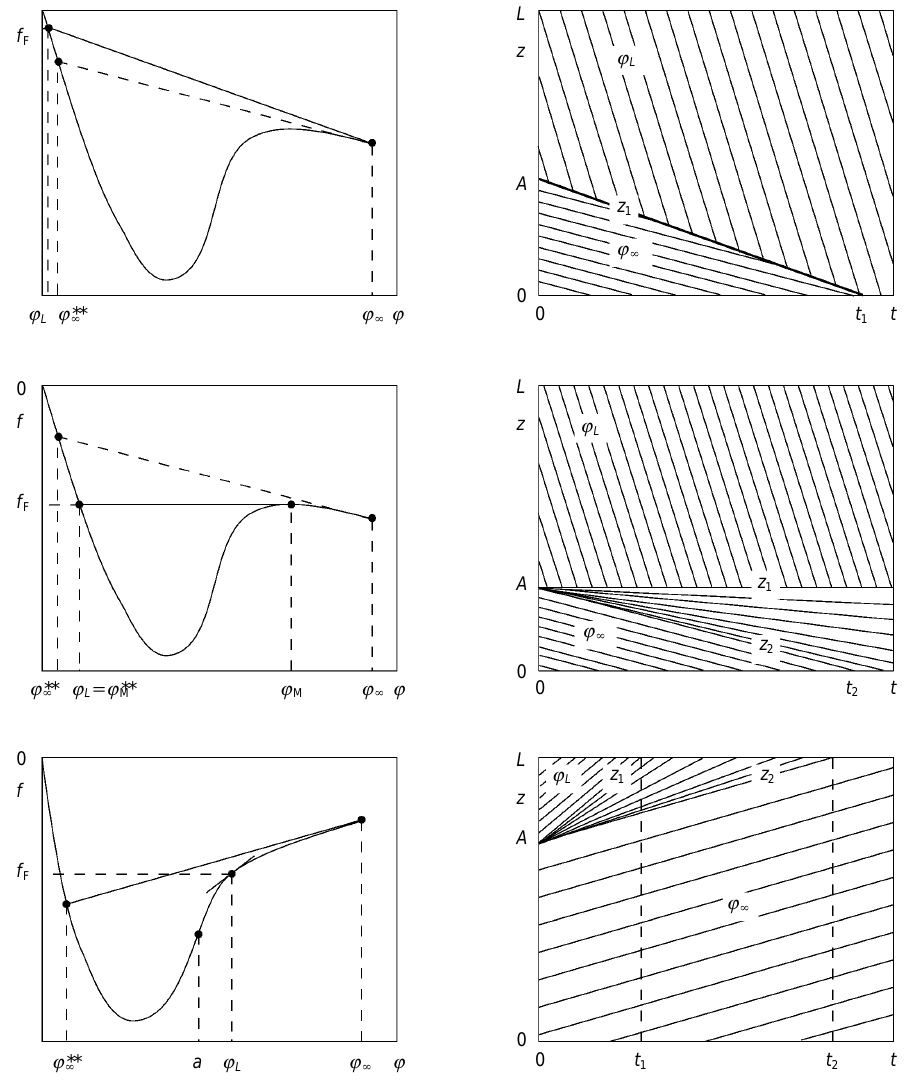
Modes of continuous sedimentation (Bustos et al. 1999). Top: MCS-1 with emptying ICT; Middle: MCS-2 attaining a steady state; Bot- tom: MCS-3 causing the ICT to